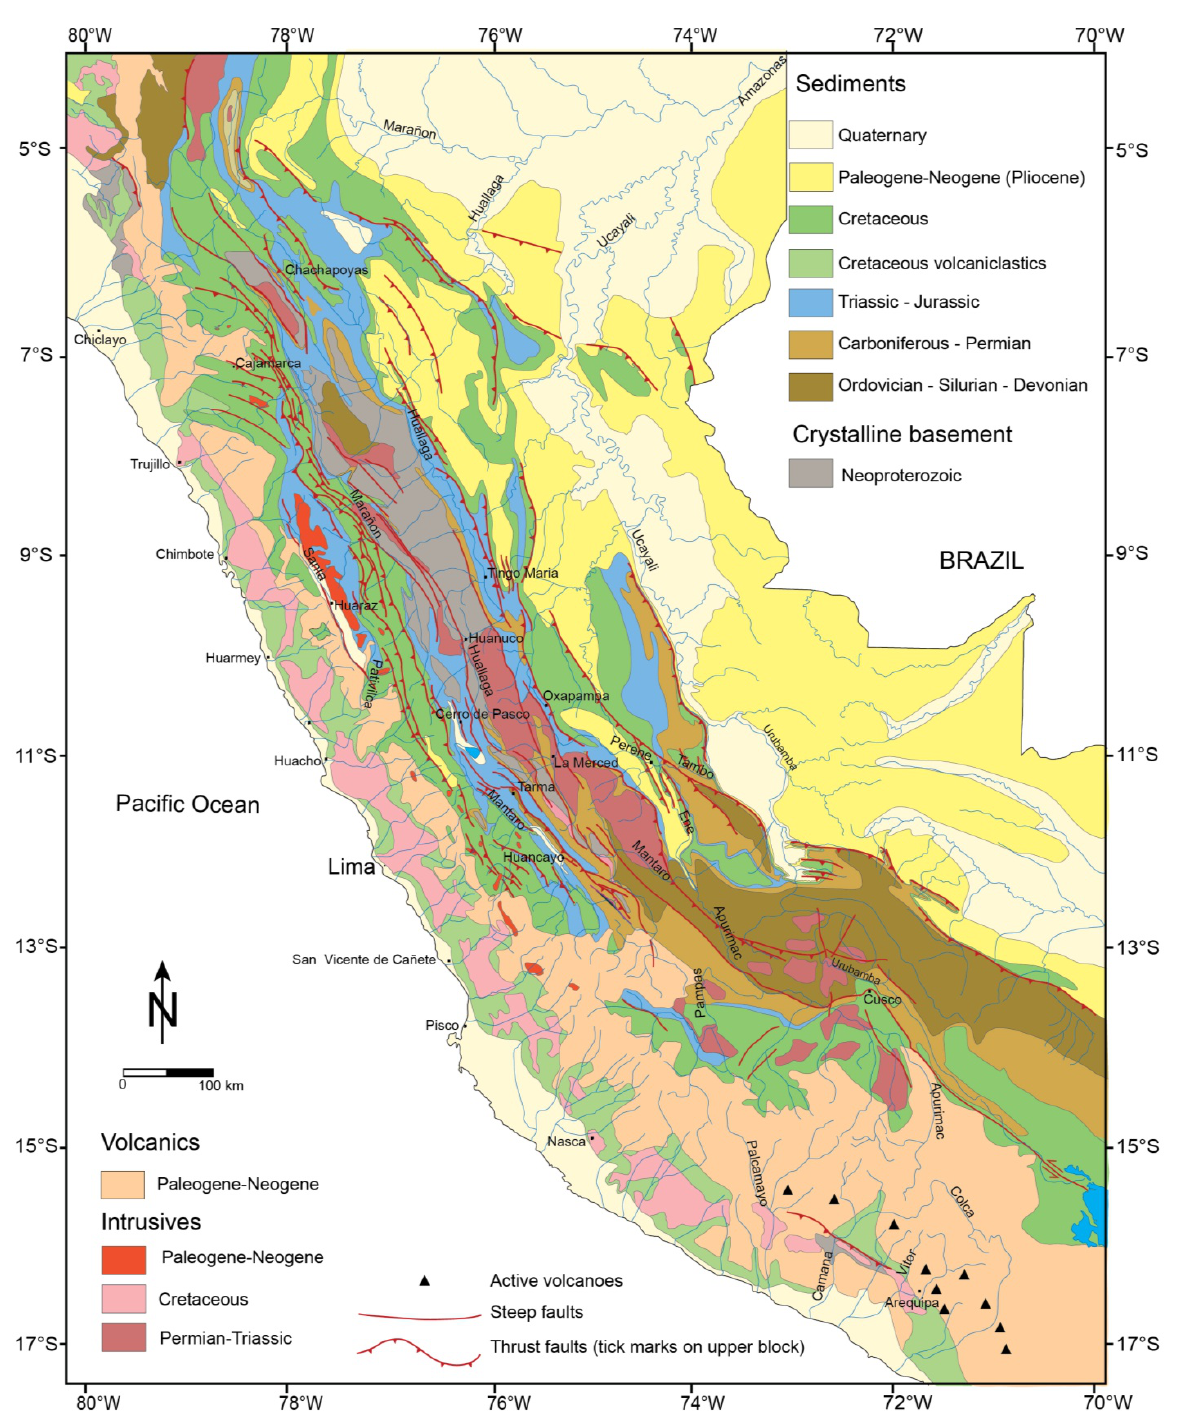
Figure 6. Structural map of the Central Andes showing the main lithotypes and faults. The map is based on local maps by [17,18,22,33,78,79], by the 1:100,000 maps of INGEMMET and own field